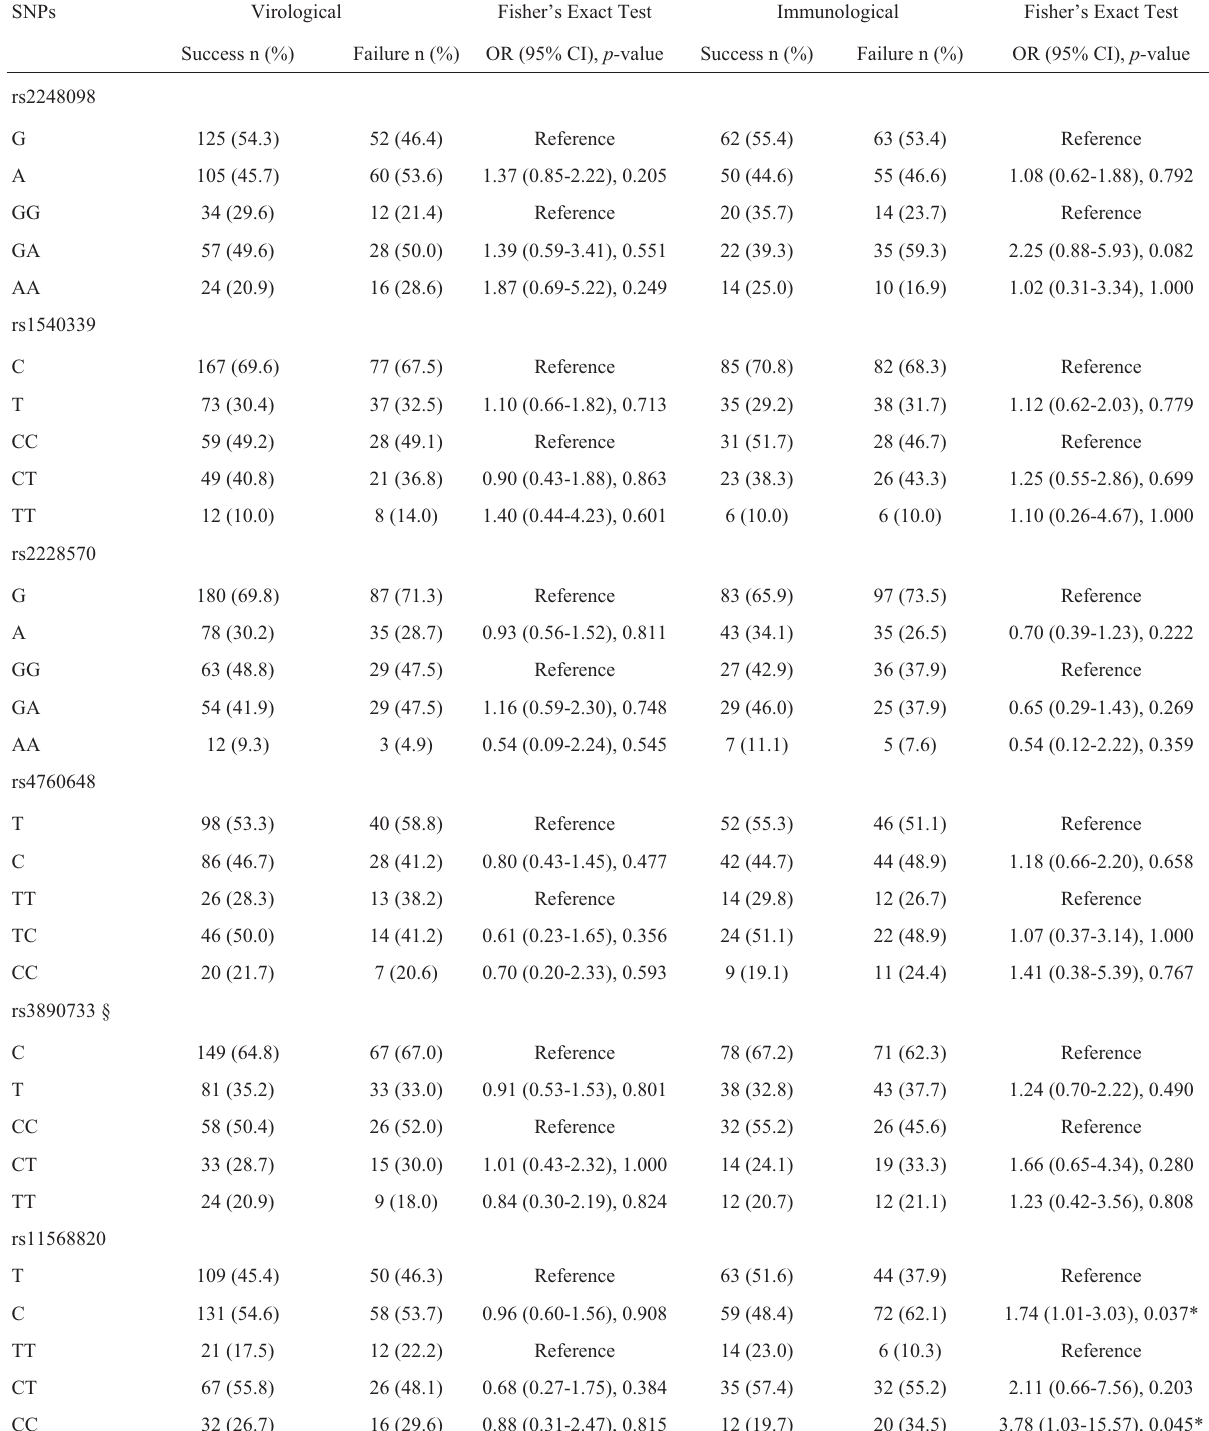
Table 2 - Allelic and genotypic frequencies of VDR SNPs in HIV-1+ patients in HAART treatment as to the virological and immunological